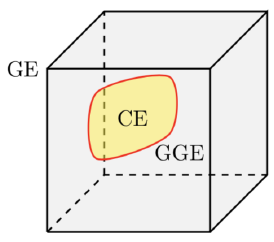
Figure 1: Sketch of the position of the GGE (red line) and CE (yellow surface) within the GE (gray volume), for symmetric root